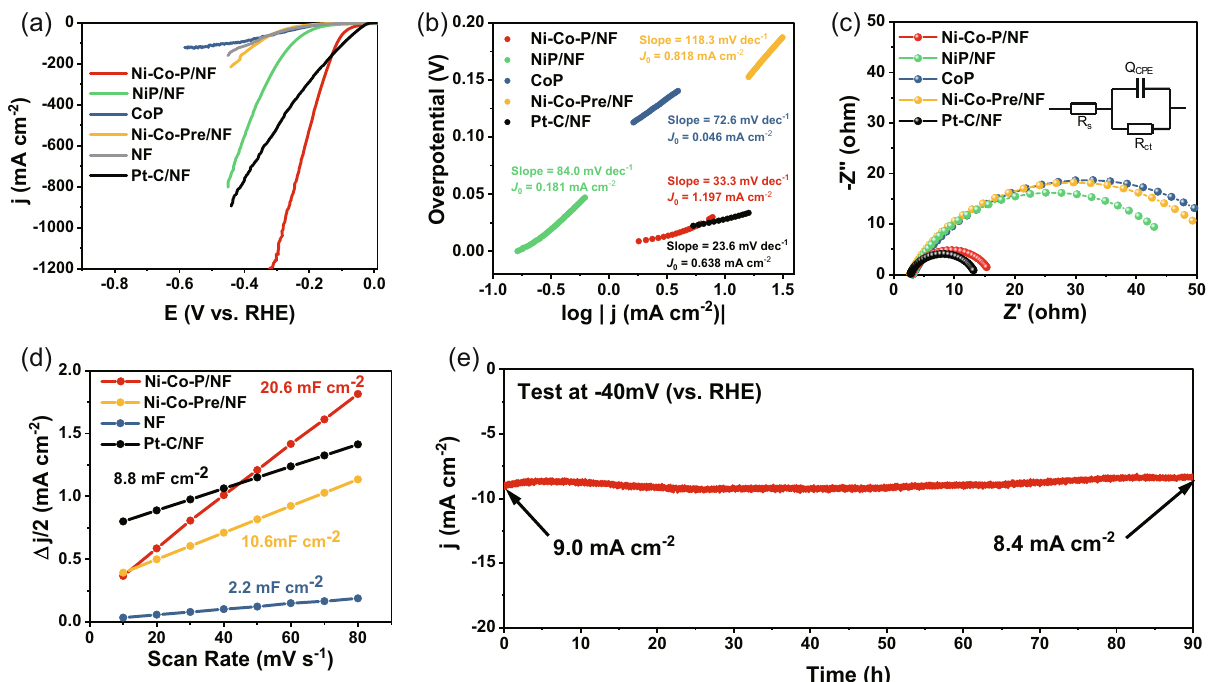
Fig. 3 | Electrochemical properties ofHER in N 2 -saturated 1.0M KOH.a 30% iR- correctedLSVcurvesatscanrateof5mVs -1 (Thecompensationresistanceisabout 0.6 Ω withthecorrespondingnon-iRcompensateddatashowninFig.S10b); b Tafel plotsand exchangecurrent densities; c Nyquist plots with the fi tting patternin the